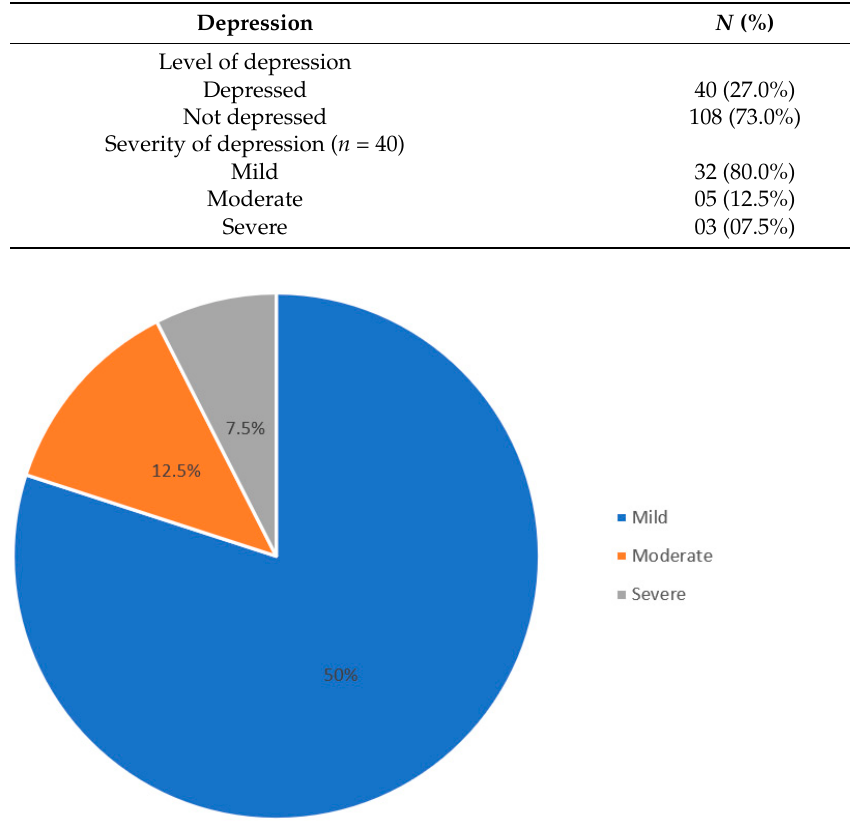
Table 2. Prevalence of depression and its severity ( n = 148).